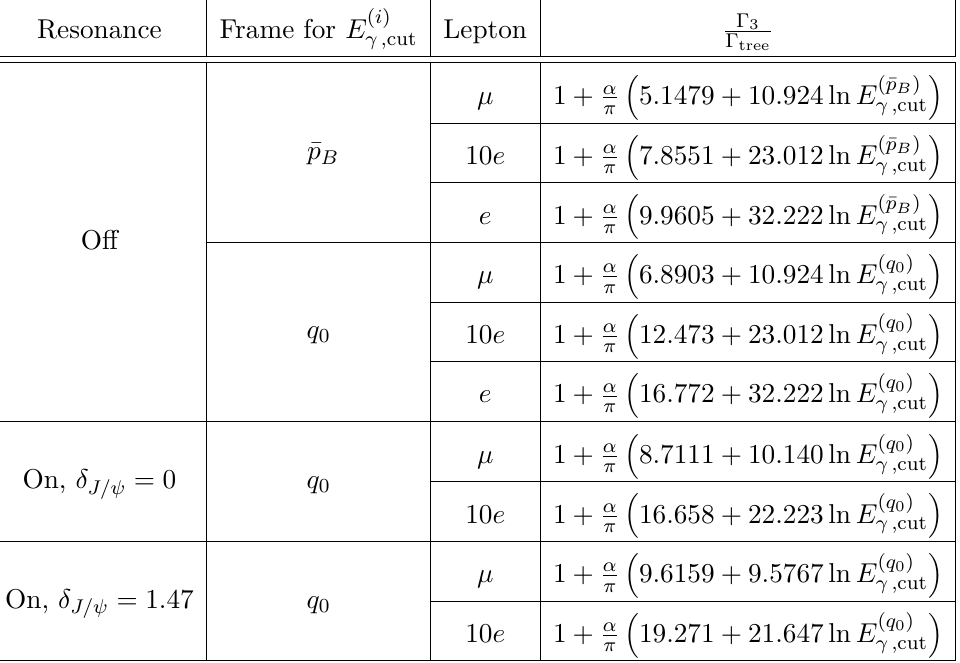
is integrated 0 ≤ 9 . 5905 GeV 2 , whereas 0 is given in ≤ 9 . 585 GeV 2 . E ( i ) 0 γ , cut